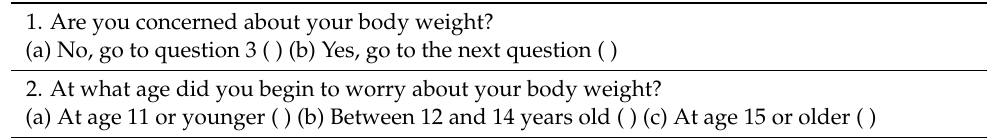
Table A3. Concerns about Bodyweight Module